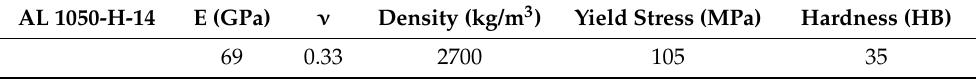
Table 1. Aluminum 1050 H14 properties